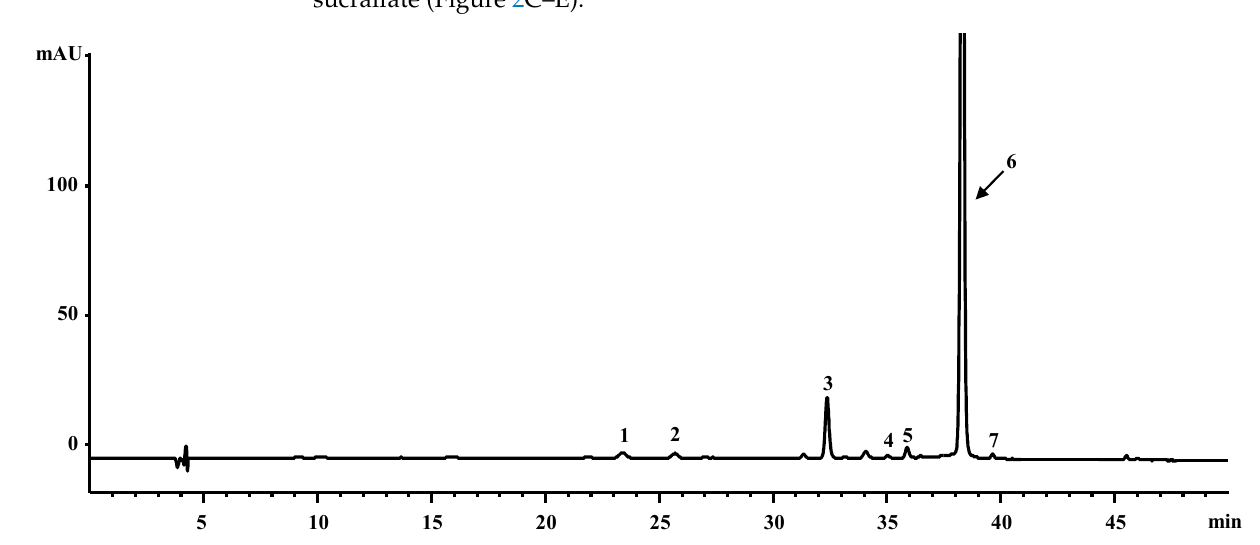
Figure 1. HPLC chromatogram of carotenoid extract (CE) from orange-fleshed sweet potato. 1 , lutein; 2 , zeaxanthin; 3 , β -cryptoxanthin; 4 , 13Z- β -carotene; 5 , α -carotene; 6 , all-trans- β -carotene; 7 , 9Z- β -carotene.